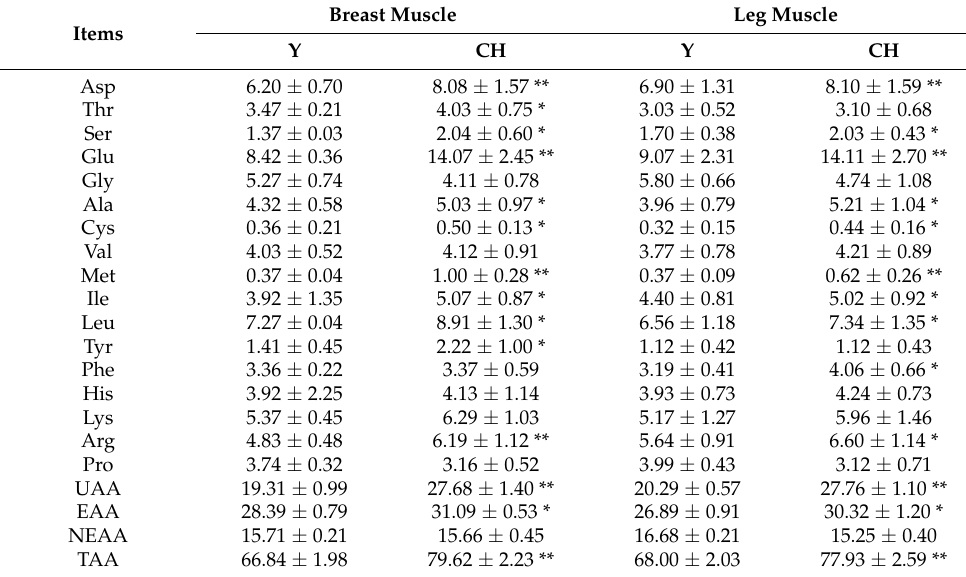
Table 2. Amino acid content in muscles of males.